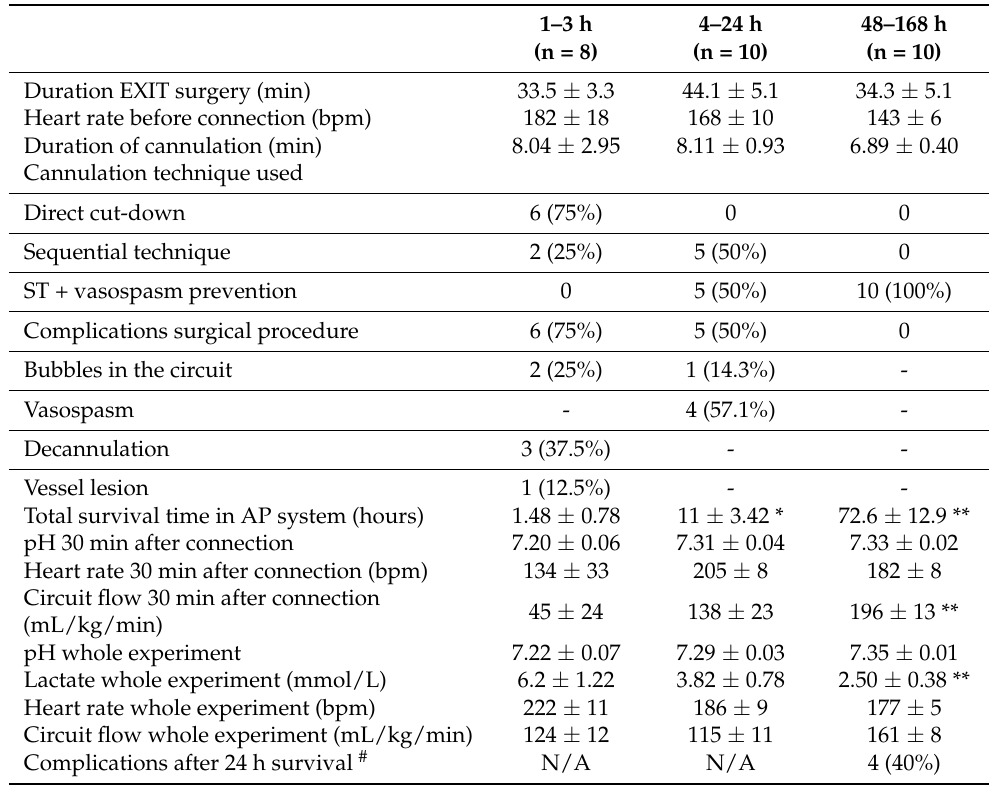
Table 1. Experimental outcomes according to survival goal